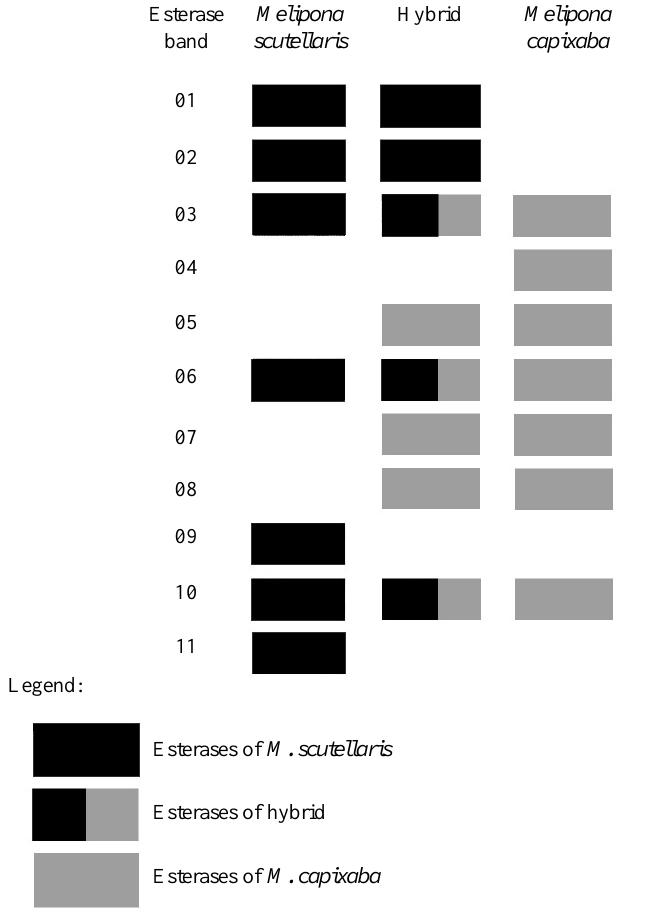
Figure 1 - Profile of esterase activity in M. scutellaris, M. capixaba and hybrid individuals. A total of 10 individuals were examined in each